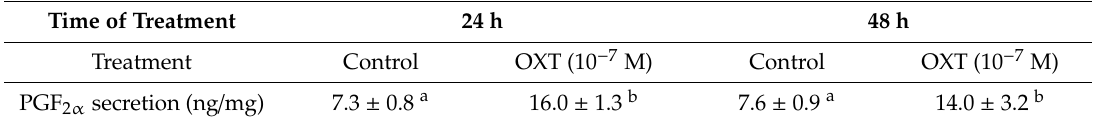
Table 4. The e ff ect of oxytocin (OXT) on prostaglandin (PG) F 2 α secretion in equine endometrial explants after 24 h or 48 h. Results are presented as means ± SEM. Di ff erent superscript letters indicate statistical di ff erences within the di ff erent time of